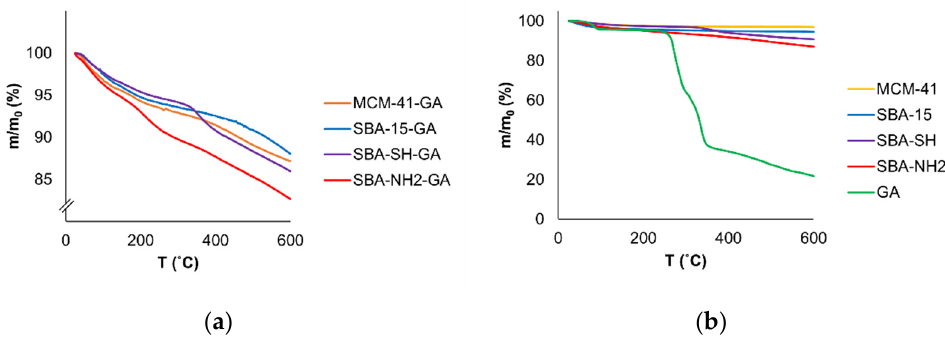
Figure A1. The TGA curves of ( a ) GA-loaded MSMs samples: MCM-41-GA (orange), SBA-15-GA (blue), SBA-SH-GA (purple), and SBA-NH2-GA (red); ( b ) reference samples before GA adsorption: MCM-41 (yellow), SBA-15 (blue), SBA-SH (purple), SBA-NH2 (red), GA (green).